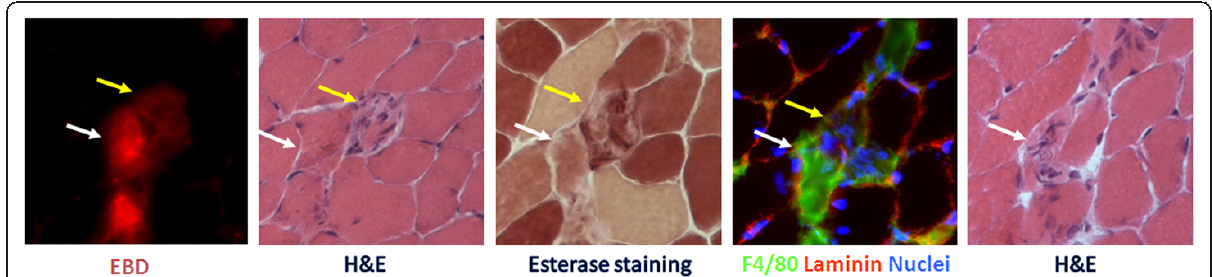
Figure 3 Macrophages infiltrate necrotic muscle fibers. Serial section of murine skeletal muscle in an area of necrosis; corresponding fibers are highlighted by matching color arrows. Evans Blue Dye (EBD) highlights muscle fibers whose plasma membrane is leaking owing to damage; hematoxylin and eosin staining (H&E), showing cellular infiltration in EBD + fibers; histochemistry for esterase staining highlights esterase-enriched macrophages; immunofluorescence analysis for activated macrophages expressing F4/80 (green) confirms the invasion of the muscle fibers by macropohages: laminin (red) and nuclei (blue) are also